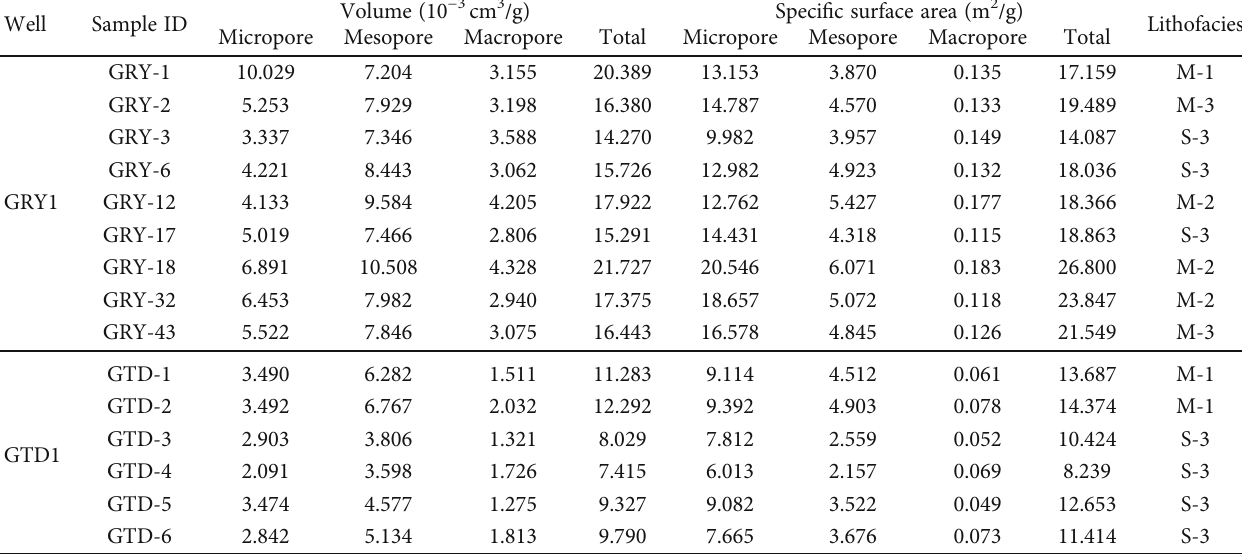
Table 2: Volumes and speci fi c surface areas of micropores, mesopores, and macropores of shale samples in GRY1 and GTD1. Well Sample